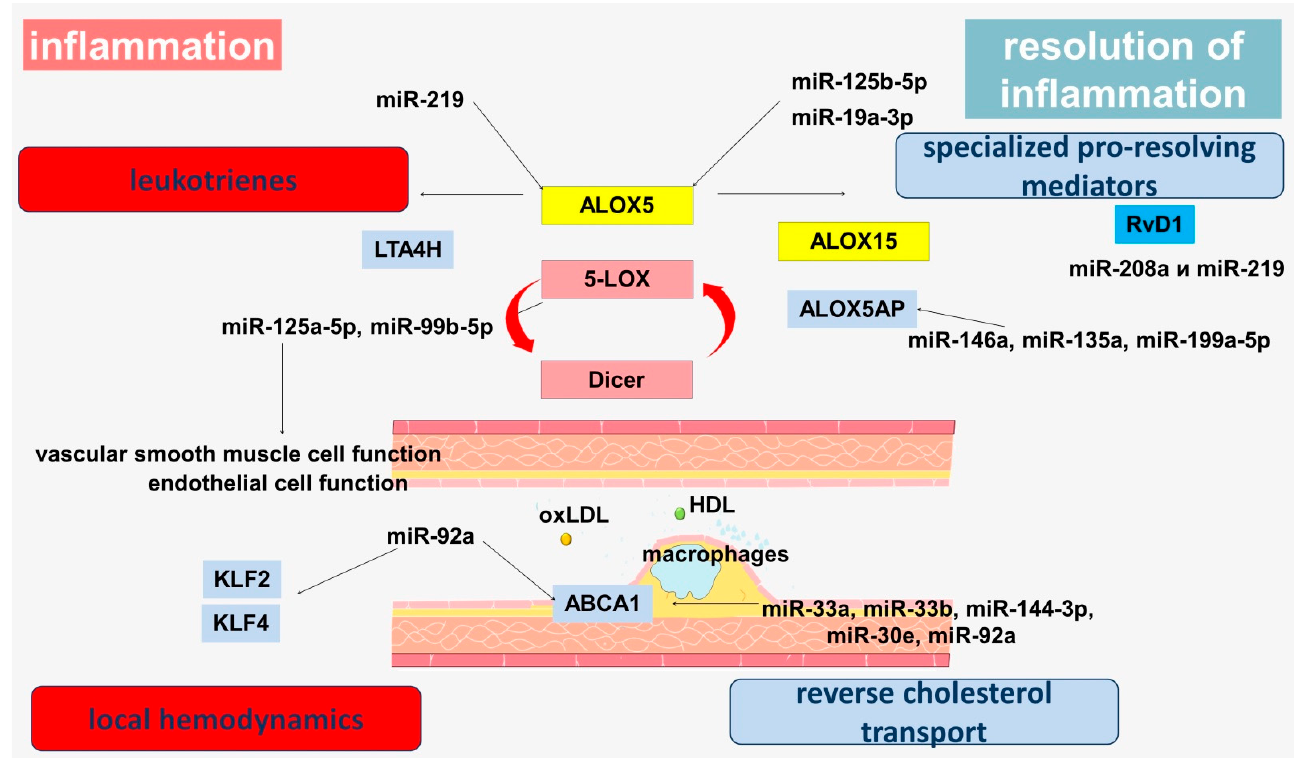
Figure 2. MicroRNA involvement in the pathogenesis of atherosclerosis. MiR-125a/b-5p in vascular endothelial cells inhibits the expression of endothelin-1 (ET-1), which is a potent vasoconstrictor peptide. It has been shown that miR-125a/b-5p can suppress oxLDL-induced ET-1 expression by targeting the 3 ′ -untranslated mRNA region of preproendothelin-1 (preproET-1) [139]. These findings demonstrate the cross-talk between vascular inflammation and hemodynamics.